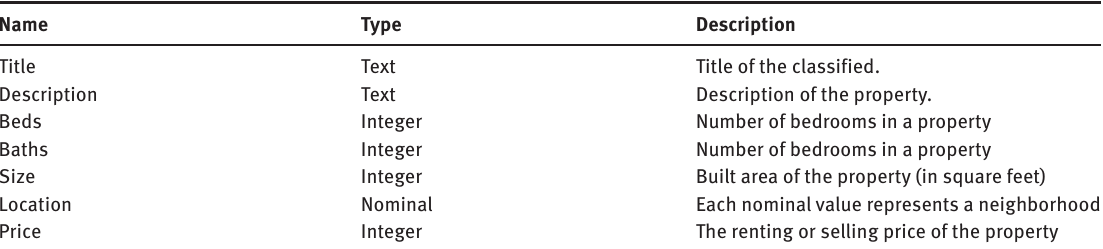
Table 2: Features of the Real-Estate Classifieds Data